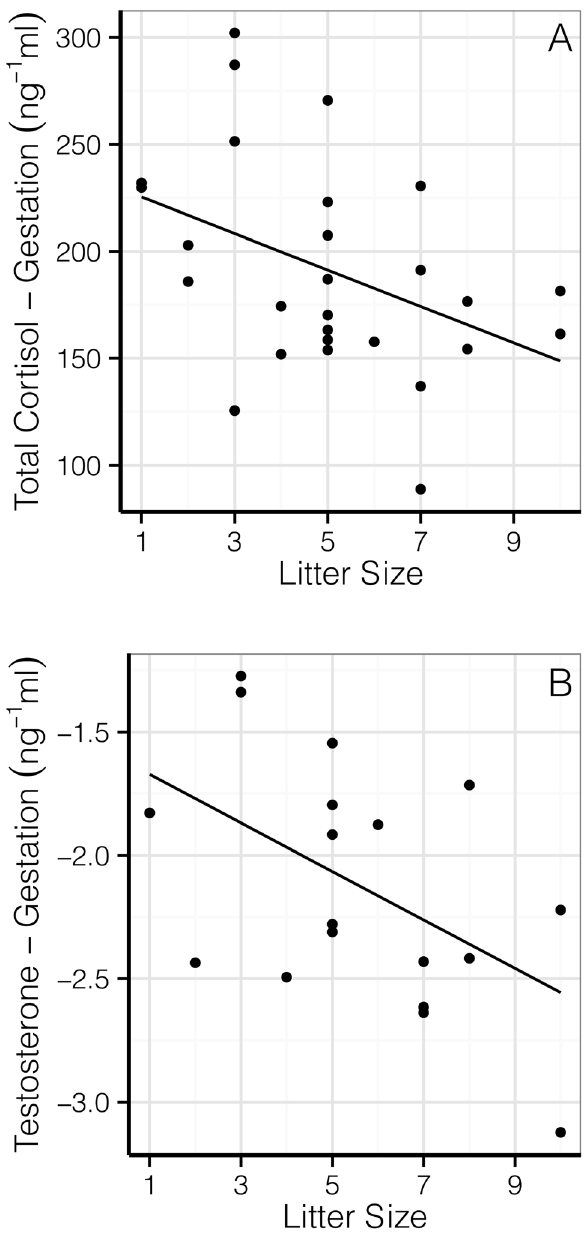
Figure 1. Relationship between total maternal gestational cortisol (A) and testosterone (B) and litter size. Both graphs show multiple points for each individual, accounted for using mixed effects models with maternal identity as a random factor ( P , 0.05 for both).